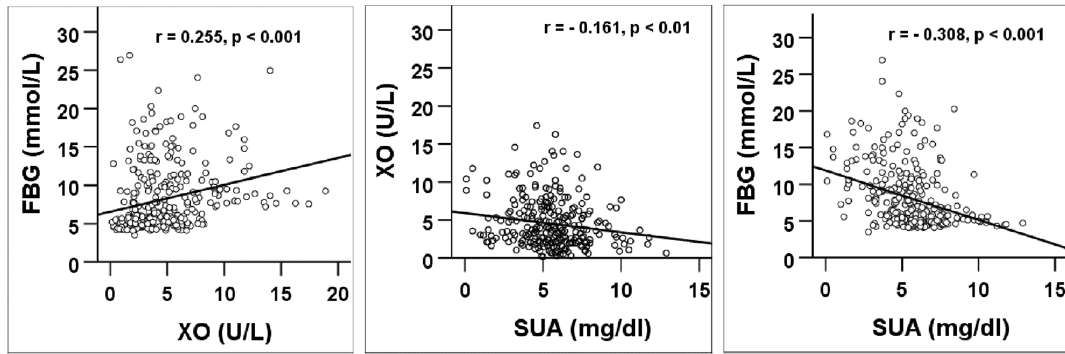
Figure 4. Correlation of XO with FBG and SUA and SUA with FBG. p values are obtained from the Pearson correlation coefficient test.